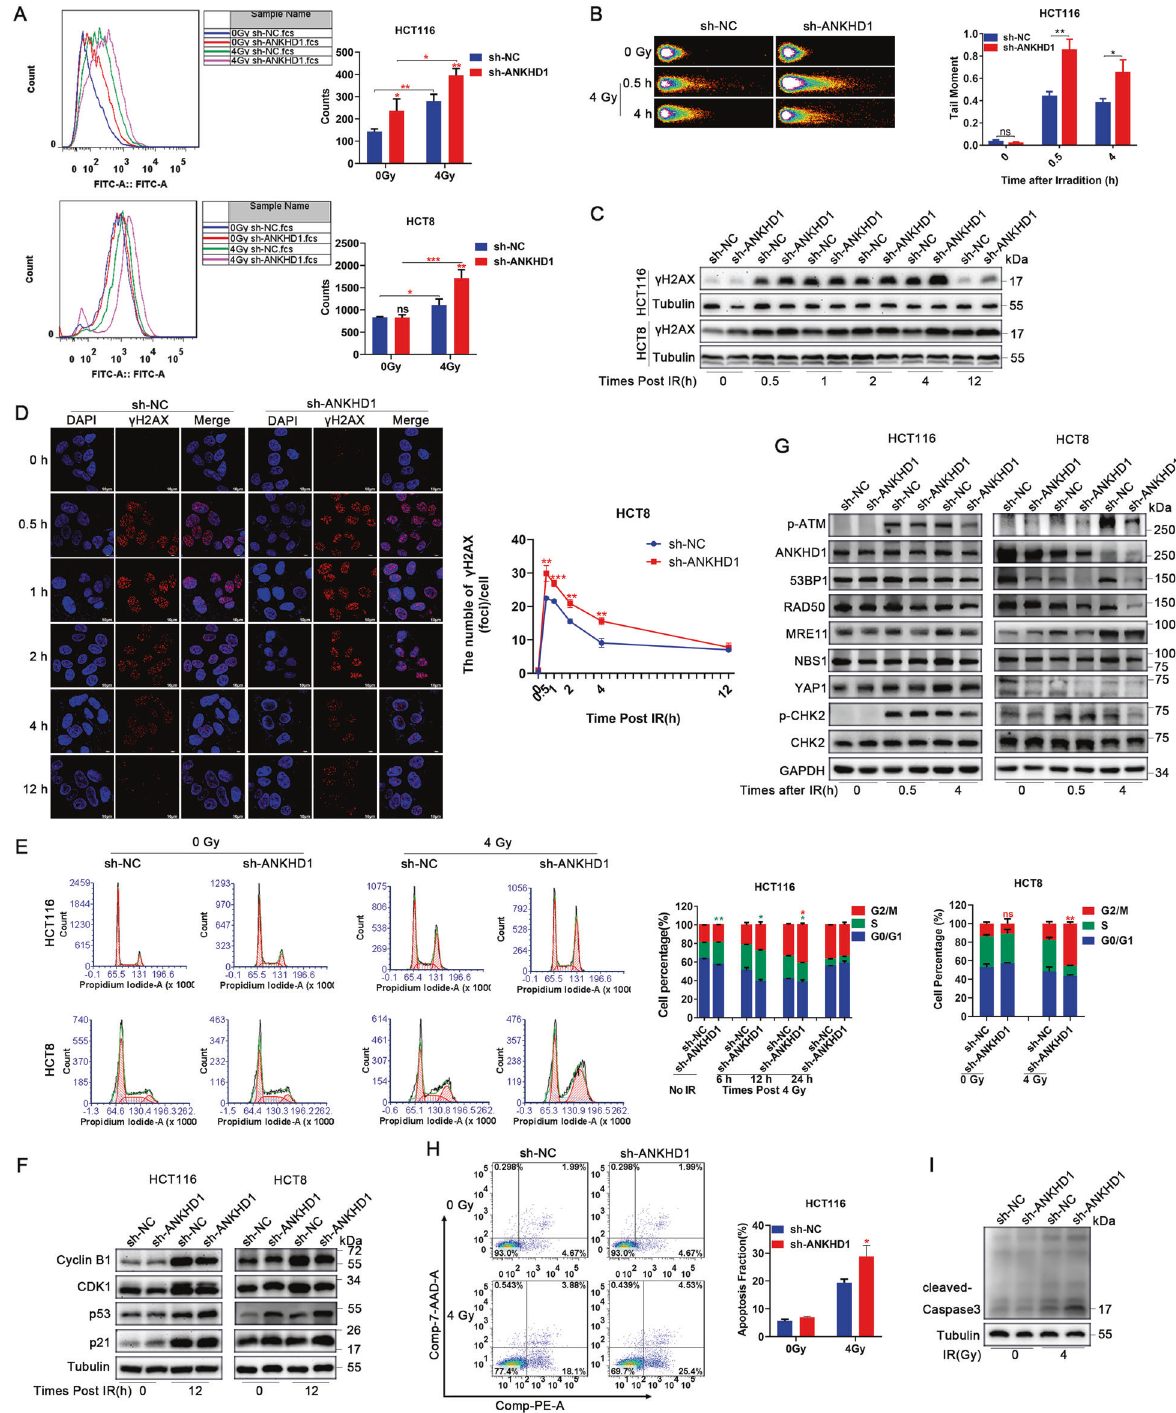
Fig. 2 ANKHD1 silencing promoted IR-induced DNA double-strand breaks by inhibiting DNA-damage repair signaling. A The formation of ROS was detected by fl ow cytometry in HCT116 and HCT8 cells with or without IR (* P < 0.05, ** P < 0.01). B A comet assay was conducted to detect DNA damage at 0, 0.5, and 4 h after 4 Gy IR, and the DNA-damage amount was quanti fi ed by measuring the comet-tail lengths (* P < 0.05). C Western blotting was used to detect γ H2AX at 0, 0.5, 1, 2, 4, and 12 h post IR. D γ H2AX foci were detected by immuno fl uorescence at 0, 0.5, 1, 2, 4, and 12 h post IR in CHT8 cells, and the γ H2AX foci number was counted from more than 100 cells (** P < 0.01). E Flow cytometry was used to detect the distribution of the cell cycle; ANKHD1-silenced cells were arrested in G2/M phase at 12 h after 4 Gy IR (* P < 0.05). F The expression of cyclin B1, CDK1, p53, and p21 was detected by Western blotting at 0 and 12 h post IR in HCT116 and HCT8 cells. G The expression of p-ATM, 53BP1, RAD50, MRE11, NBS1, YAP1, and p-CHK2 was detected by Western blot at 0, 0.5 and 4 h post IR in HCT116 and HCT8 cells. H ANKHD1 silencing increased apoptosis at 48 h post IR in HCT116 cells (* P < 0.05). I ANKHD1 silencing increased the expression of cleaved-caspase 3 at 48 h post IR.